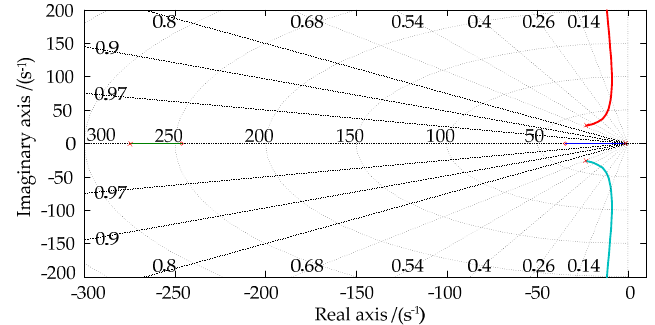
Figure 9. The root locus of the closed loop system after adding the improved PR controller.